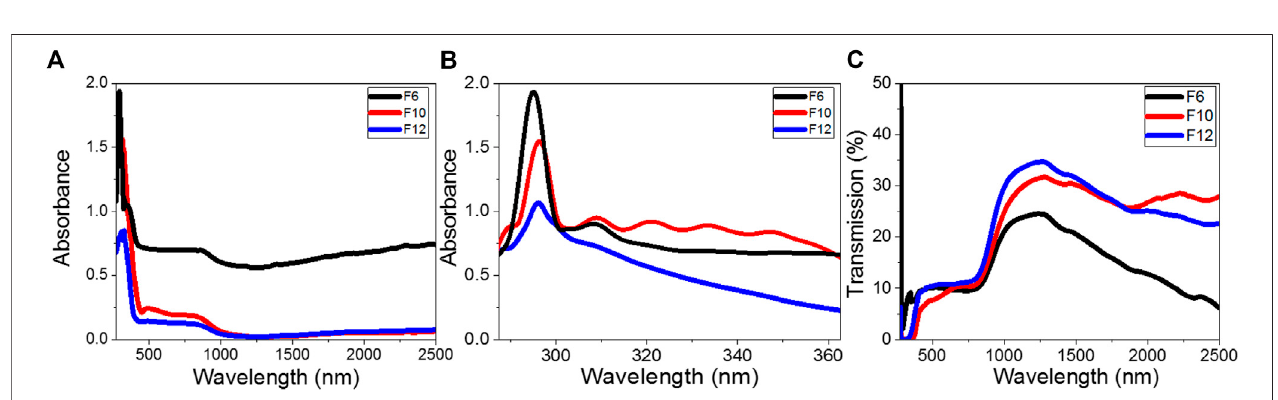
FIGURE 5 | Optical (A,B) absorbance and (C) transmission spectra of F 6 , F 10 , and F 12 fi lms.